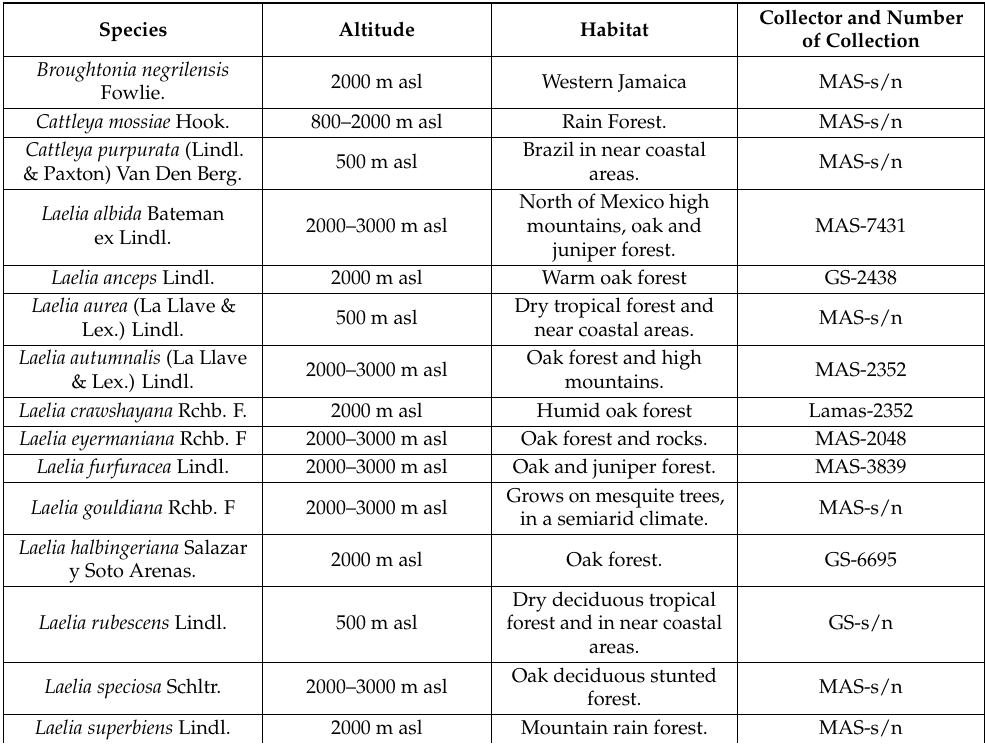
Table 3. Species of Laeliinae subtribe analyzed. The altitude and habitat are described for each species (data taken from Halbinger and Soto, 1997) [7]. Als : above sea level. Collectors: GS = Gerardo Salazar; MAS = Miguel Á ngel Soto. s/n: no number assigned. Collector and Number Species Altitude Habitat of Collection Broughtonia negrilensis 2000 m asl Western Jamaica MAS-s/n Fowlie. Cattleya mossiae Hook. 800–2000 m asl Rain Forest. MAS-s/n Brazil in near coastal 500 m asl